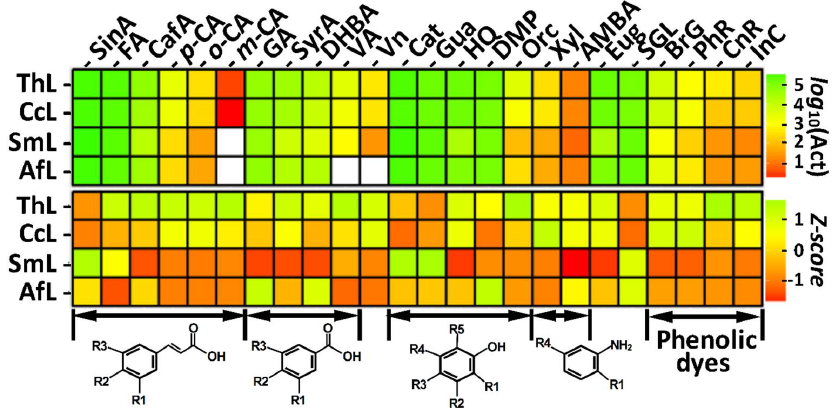
Figure 1. Laccase activities toward different phenolic substrates. The following abbreviations are used: SinA = synapic acid, FA = ferulic acid, CafA = caffeic acid, p -CA = p -coumaric acid, o -CA = o -coumaric acid, m -CA = m -coumaric acid, GA = gallic acid, SyrA = syringic acid, DHBA = 3,4-dihydroxybenzoic acid, VA = vanillic acid, Vn = vanillin, Cat = catechol, Gua = guaiacol, HQ = hydroquinone, DMP = 2,6-dimethoxyphenol, Orc = orcinol, Xyl = 2,5-xylidine, AMBA = 2-amino-4-methoxybenzoic acid, Eug = eugenol, SGL = syringaldazine, BrG = bromocresol green, PhR = phenol red, CnR = congo red, and InC = indigo carmine, ThL = Trametes hirsuta laccase, CcL = Coriolopsis caperata laccase, AfL = Antrodiella faginea laccase, and SmL = Steccherinum murashkinskyi laccase. The white cells on the upper panel represent points where no activity was detected. The Z-scores were obtained by standardization of the original activities for each substrate (table column) separately. The general patterns in the substrate structures are described/depicted under the corresponding entries and the details are described in the main text.